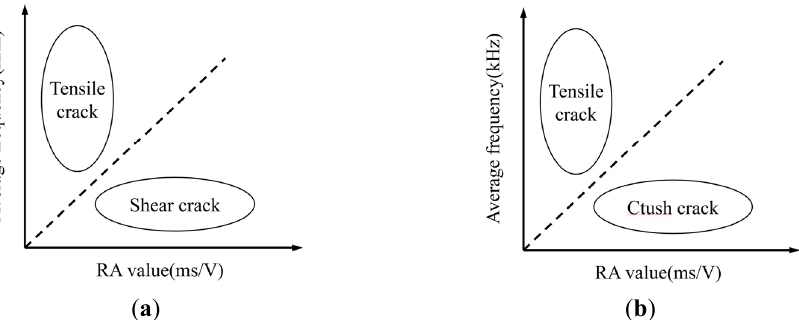
Figure 9. Relationship between crack patterns and RA-AF value: ( a ) Unconfined concrete, ( b ) FRP confined concrete [31].